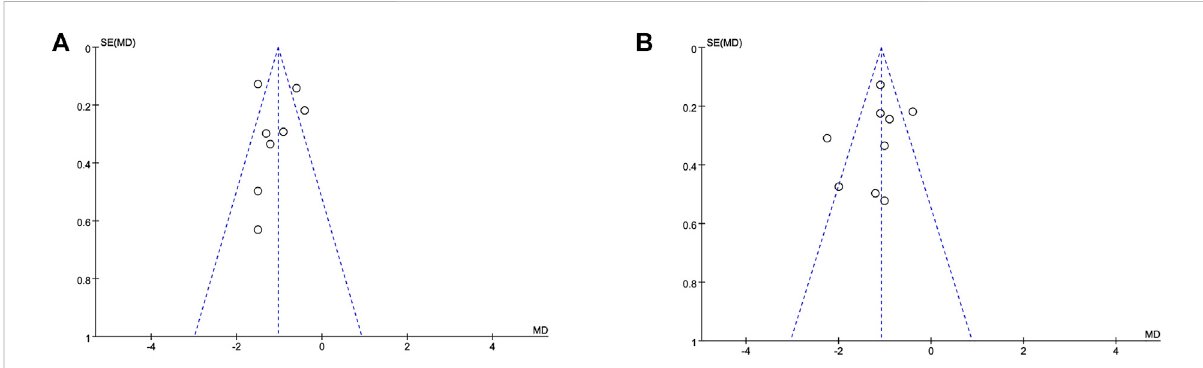
FIGURE 4 Funnelplotbasedonthepainscores.Abbreviations:MD,meandifference. (A) Funnelplotbasedonthepainscoresat12 h. (B) Funnelplotbased on the pain scores at 24